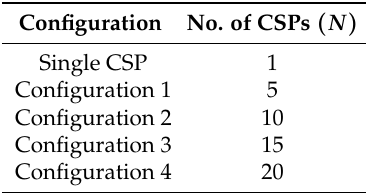
Figure 8. Distribution time when F P = 1 TB, v = 100 Mbps. Table 3. Configuration for distribution time